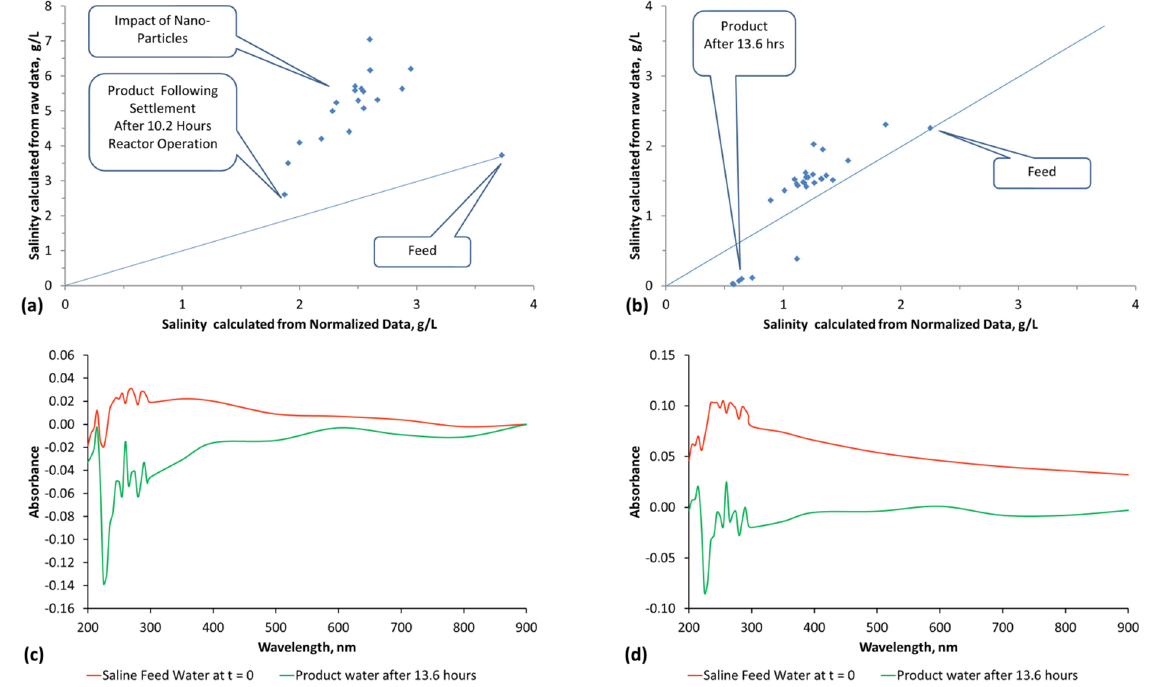
Figure E2. Salinity calculated from raw spectra and normalized cuvette corrected spectra. Reactor contains 0.24 m 3 . Operating temperature of water = 15–22 °C (varying with atmospheric temperature). Reusable cartridge contains 0.4 kg ZVM TPA when new. Saline water constructed by dissolving halite (Cheshire) in spring water. ( a ) Feed water salinity and growth of nano-particle concentration during reactor operation (10.2 h) and product salinity following settlement; ( b ) Feed water salinity and minor growth of nano-particle concentration during reactor operation and product salinity after 13.6 h; ( c ) Normalized feed water and product water absorbance after 13.6 h; ( d ) Raw feed water and raw product water absorbance after 13.6